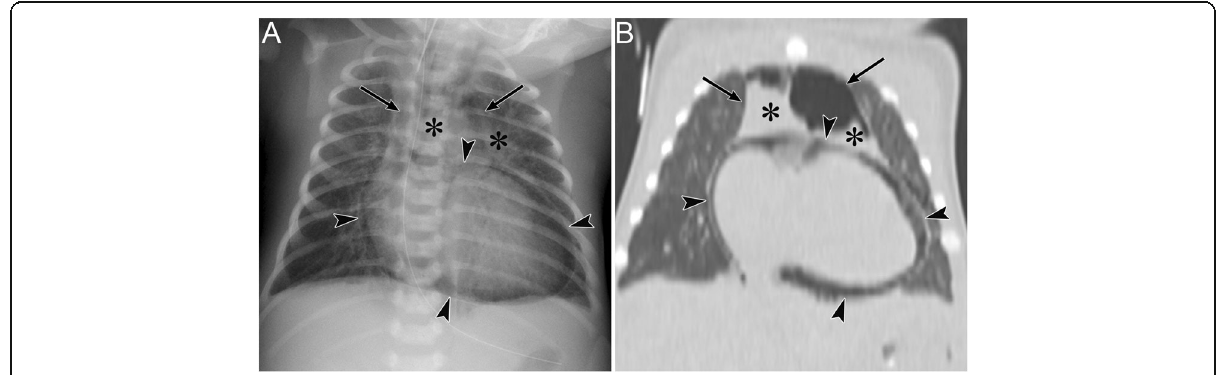
Fig. 15 Pneumomediastinum and pneumopericardium in a 3-day-old girl with pulmonary atresia. Pneumomediastinum is caused by the obstruction and check valve effect of the tracheal tube with pulmonary secretions. a A supine radiograph shows the “ spinnaker sail ” sign with thymus elevation (asterisks) by pneumomediastinum (arrows). Pneumopericardium (arrowheads) is also visible. b A coronal CT image reveals pneumomediastinum (arrows) surrounding the thymus (asterisks) and pneumopericardium